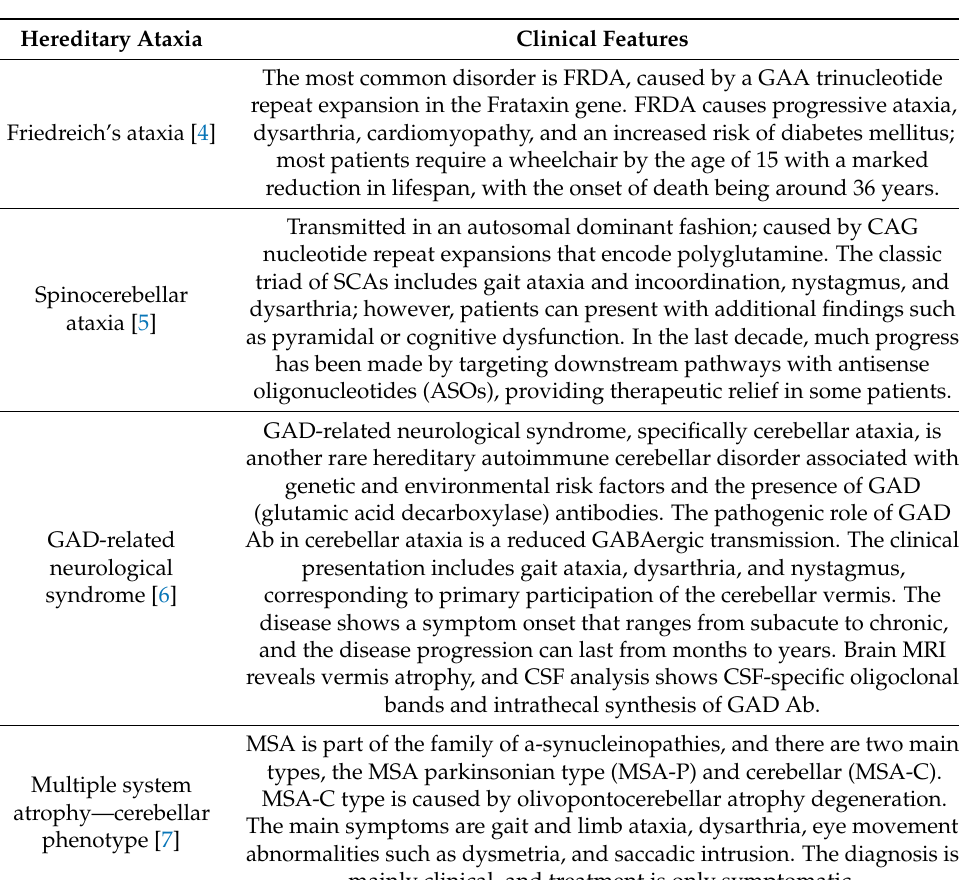
Table 1. Main features of these hereditary